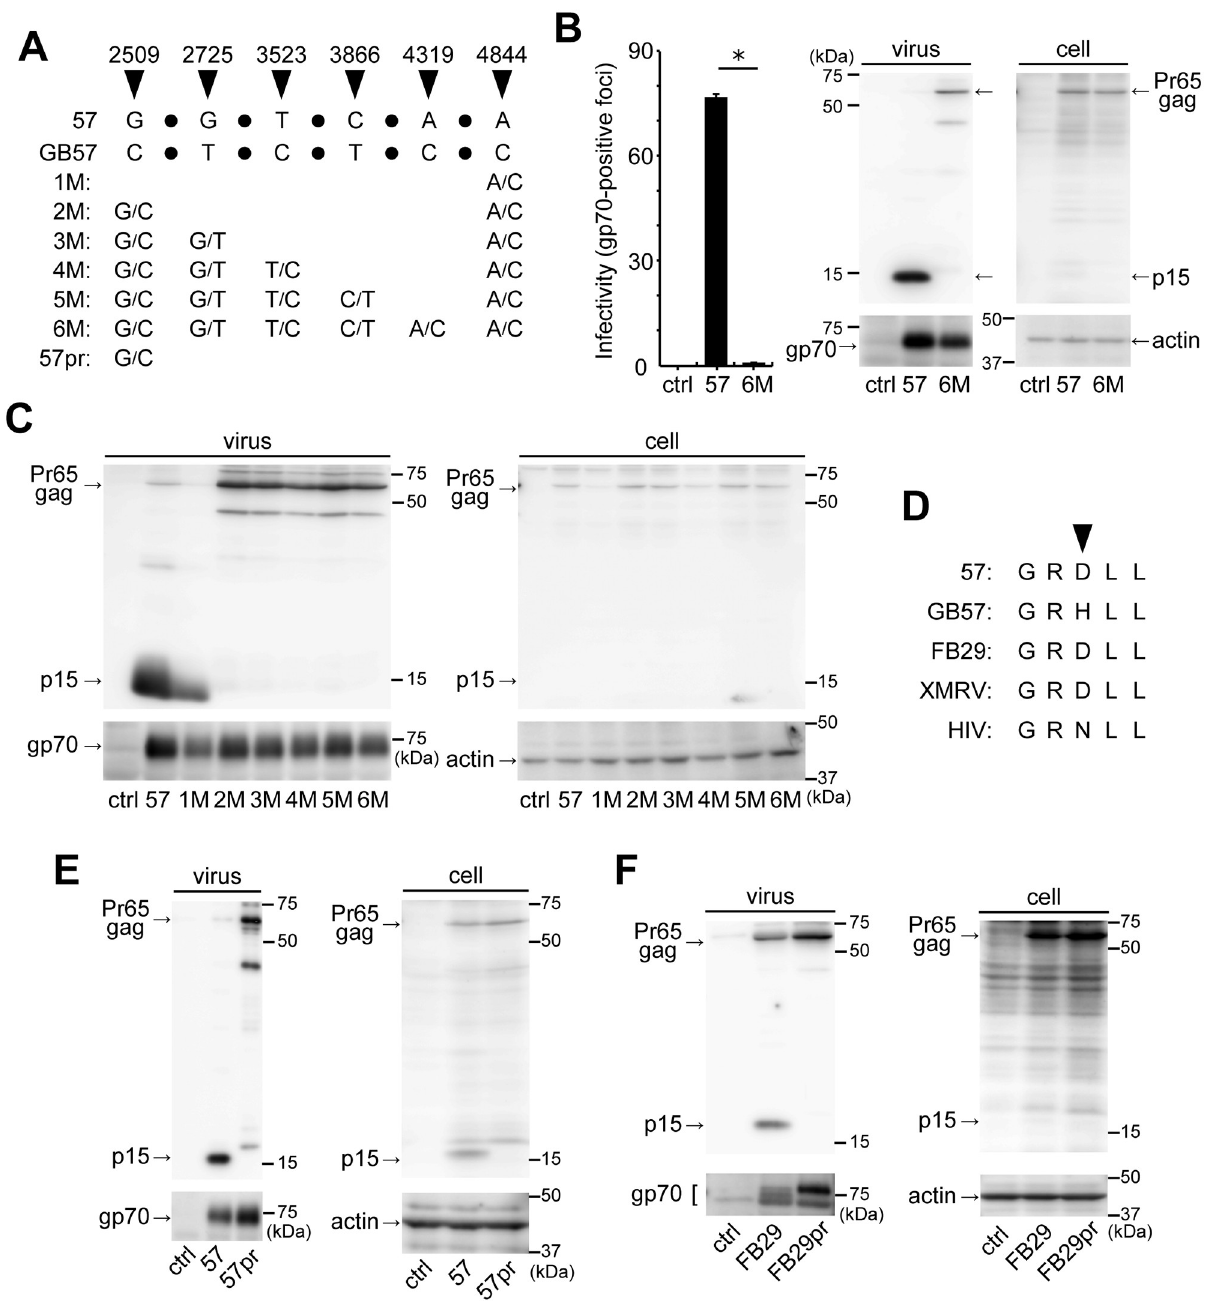
Fig 1. Infectious F-MuLV molecular clones and their protease-deficient mutants. (A) A diagrammatic alignment of p57(2LTR)Sp72 (57) and GB57 sequences. The latter is enrolled in GenBank (accession number X02794). Discrepancies are indicated by arrowheads and corresponding nucleotide position numbers. Sequences in between these discrepant residues are omitted and represented by filled circles. Mutants (1M to 6M and 57pr) were generated with the strain 57 sequence as the backbone with the indicated GB57-type nucleotide substitutions. The strain 57 sequence in p57(2LTR)Sp72 has been registered in DDBJ with the accession number LC229035. (B) Infectivity of strain 57 and 6M viruses. Viruses were produced from 293T cells transfected with either one of the virus-encoding plasmids. As a control (ctrl), the cells were mock-transfected with a control vacant plasmid. A portion of the culture supernatant was used for the infectivity assay in which virus infectivity was evaluated by counting the number of gp70-positive foci on Mus dunni cells. Results are shown as a mean with standard error of more than 3 wells. � , P = 0.0004 by Student’s t -test. Experiments were repeated three times with similar results. The remaining virus-containing supernatant was subject to ultracentrifugation to collect the viruses. The pelleted viruses and the transfected 293T cells were lysed for immunoblotting. To detect the matrix protein (p15) and its precursor, Pr65gag, the anti-p15 mAb (clone 690) was used. The envelope protein (gp70) was also detected to monitor virus production using the anti-F-MuLV gp70 mAb (clone 720). Actin